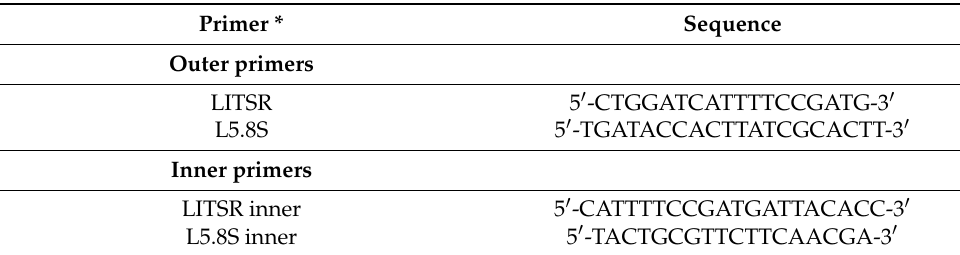
Table 1. ITS1 and modified nested PCR primer